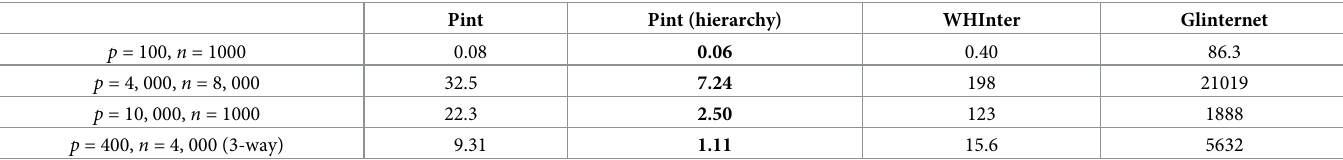
Table 2. Mean time taken (s) for simulated data sets. Pint Pint (hierarchy) WHInter